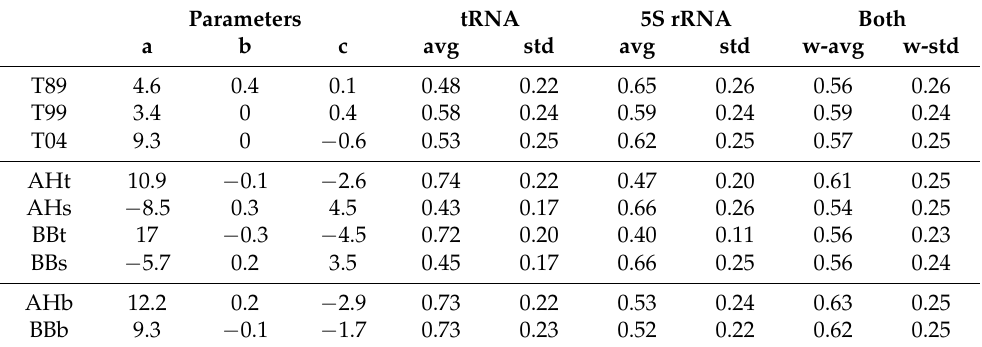
Table 3. MFE prediction accuracies for testing data set from Mathews Lab (U Rochester) with 557 tRNA sequences and 1283 5S rRNA. Table 2 parameters repeated for